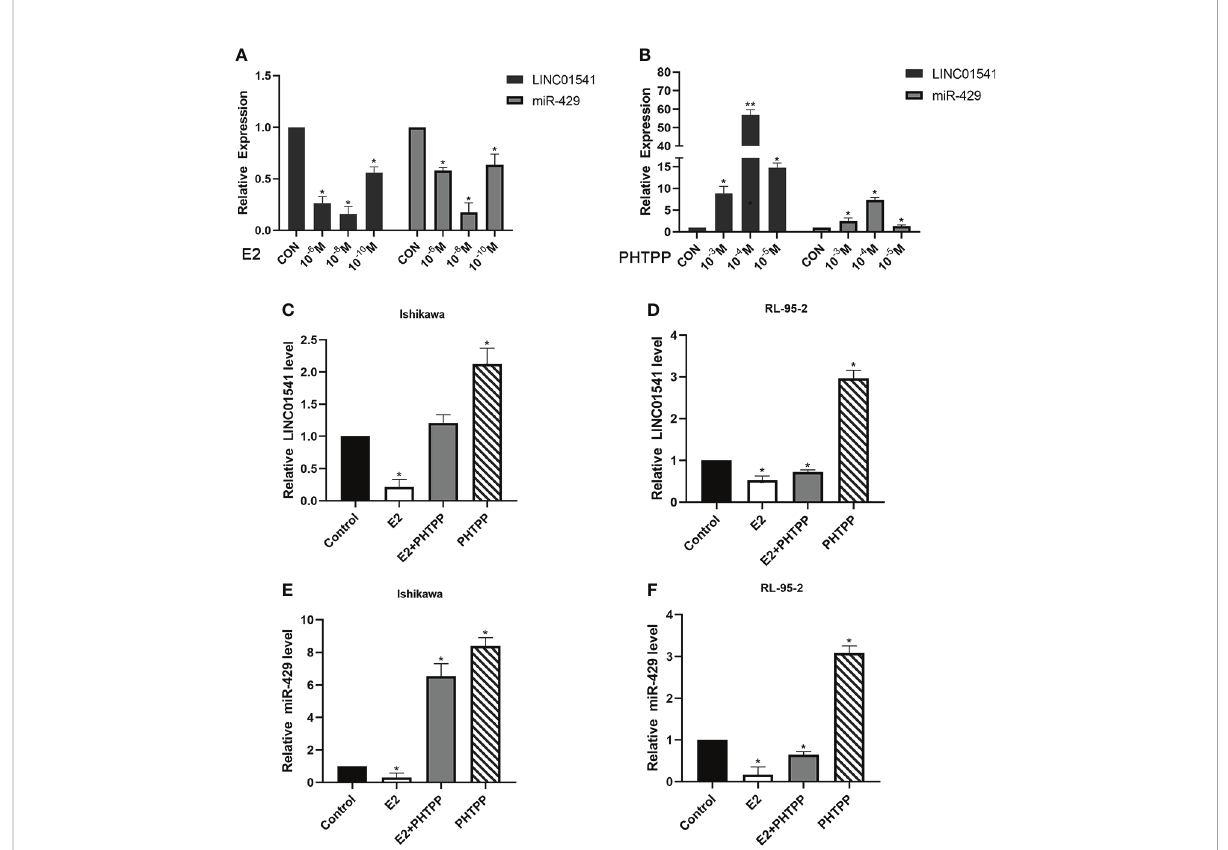
FIGURE 2 qRT-PCR was used to detect the effect of E2 and PHTPP in EAC cells. (A) The down-regulation of LINC01541 and miR-429 was most obvious when the concentration of E2 was 10 -8 mol/L. (B) The down-regulation of LINC01541 and miR-429 was reversed most obviously when the concentration of PHTPP was 10 -4 mol/L. (C-F) In Ishikawa and RL95-2 cell lines, E2 inhibited the expression of LINC01541 and miR-429, whereas PHTPP was able to reverse this effect. (* P <0.05; ** P